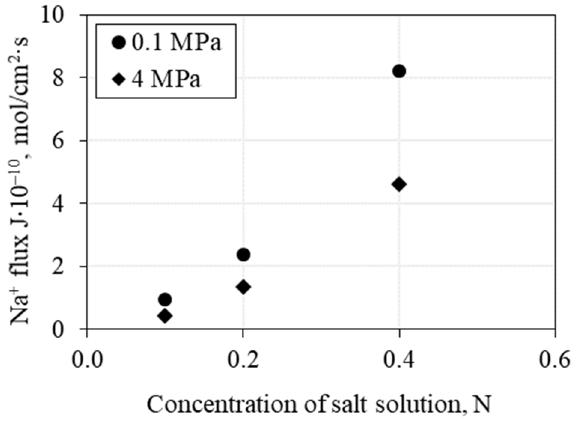
Figure 11. Variations of Na + contents in frozen hydrate-bearing sand after four hours of interaction with a NaCl solution of different concentrations, at − 6.5 °C and p = 0.1 and 4.0 MPa.